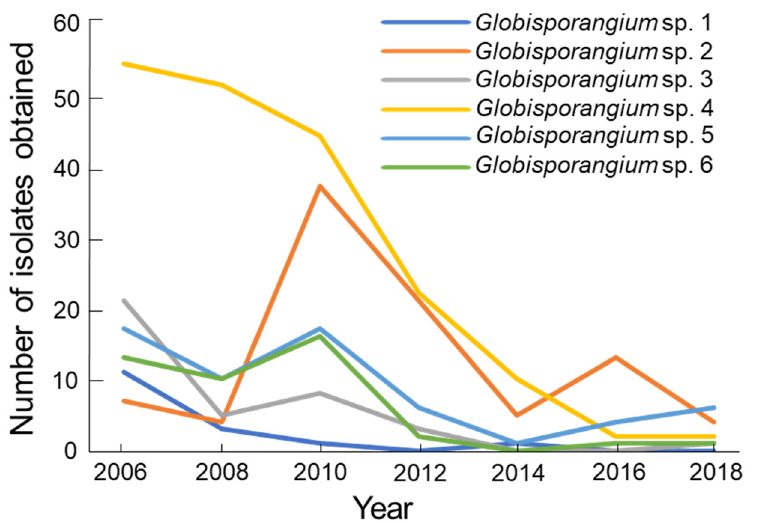
Figure 7. Total number of isolates of Globisporangium sp. 1, sp. 2 (= G. polare ), sp. 3, sp. 4, sp. 5 and sp. 6 from a single colony of Sanionia moss at the north-side cliff of Ny-Ålesund, Spitsbergen Is., Norway from 2006 to 2018. The investigations were carried out in August each year for the six sampling plots shown in Figure 1.